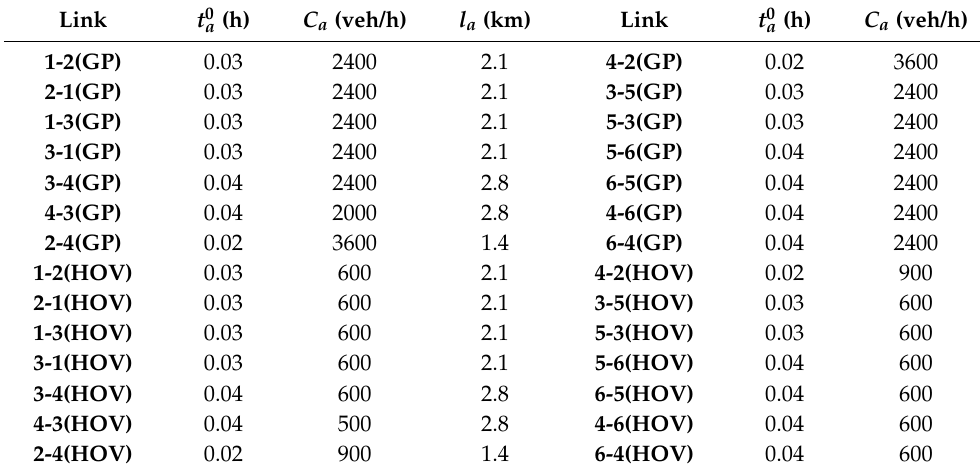
Table 2. Free-flow travel time, capacity, and length of